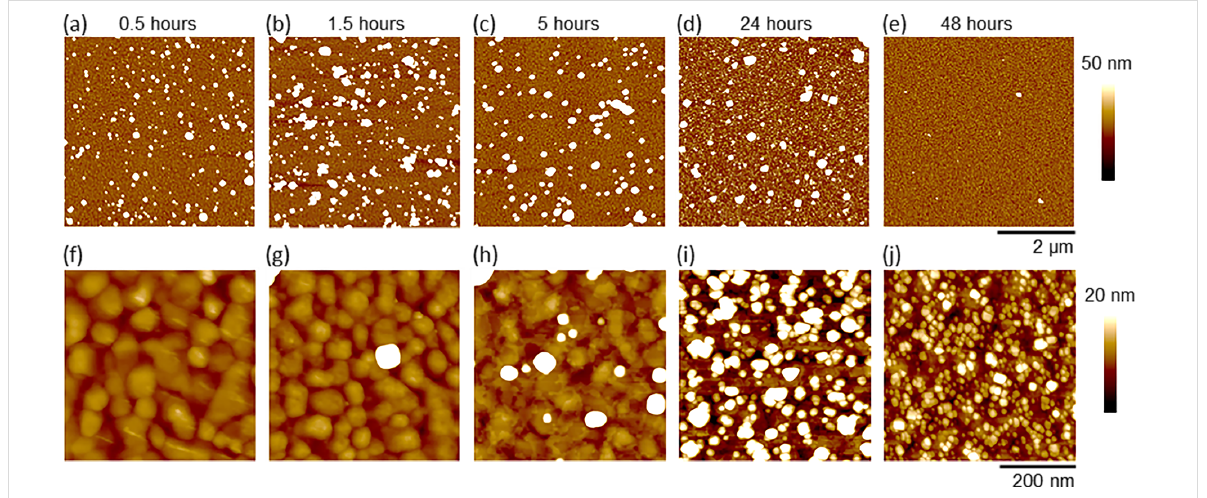
Figure 1: Representative AFM images of HKUST-1 surMOFs fabricated via codeposition at 25 °C on SAM-coated Au surfaces. Samples were syn- thesized over varied lengths of time (as indicated above each column of images). Shown in (a–e) are 5 μ m × 5 μ m images set to the same z -scale (50 nm) and shown in (f–j) are 500 nm × 500 nm images set to the same lower z -scale (20 nm) to visually render the smallest particles on the sub- strate. The higher magnification images were taken in regions between the largest MOF crystallites and selected specifically to characterize the smallest crystallites nucleated on the surface. Note the gold grain structure in the background of these higher resolution images.